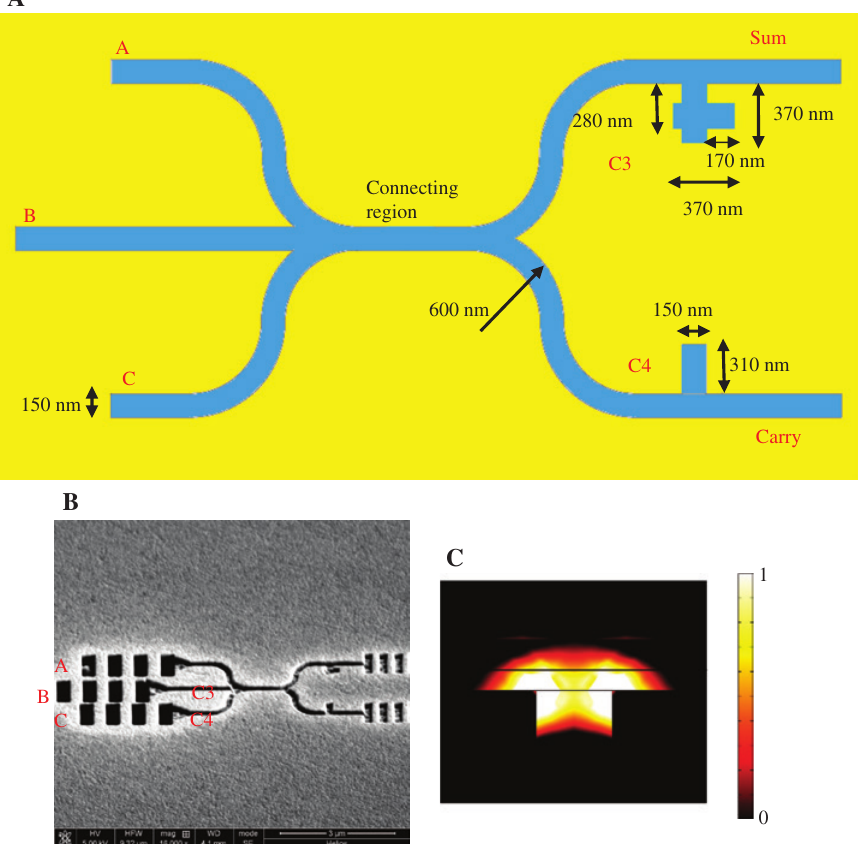
Figure 2: Configuration of the full-adder sample. (A) Schematic structure of the full-adder without the nano-Au:(IR140:MEH-PPV) nanocom- posite cover layer, consisting of X-shape-crossed plasmonic waveguides side-coupled two plasmonic nanocavities etched in a 300-nm-thick gold film. (B) The SEM image of the full-adder sample without the nano-Au:(IR140:MEH-PPV) nanocomposite cover layer. (C) Calculated power density profile of the SPP mode in the plasmonic composite nanocavity C3 having the nano-Au:(IR140:MEH-PPV) cover layer under excitation of an 800-nm CW incident